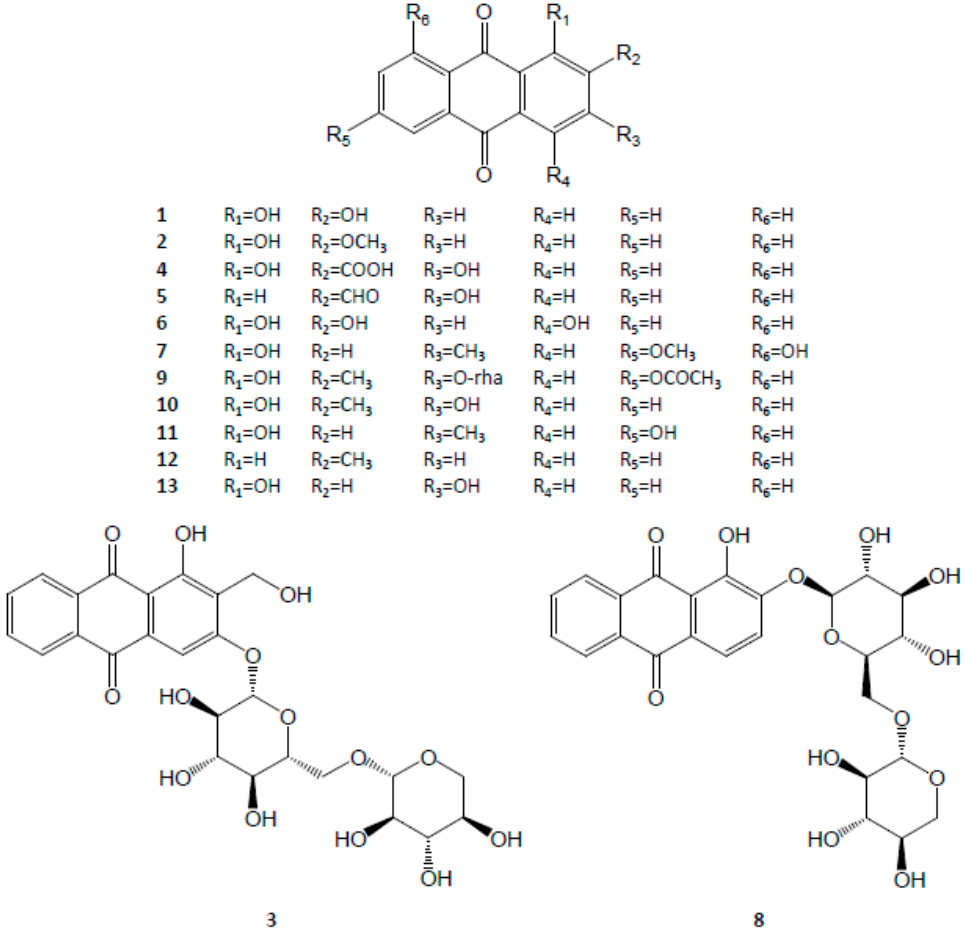
Figure 2. Structures of anthraquinones in Rubiae Radix et Rhizoma.